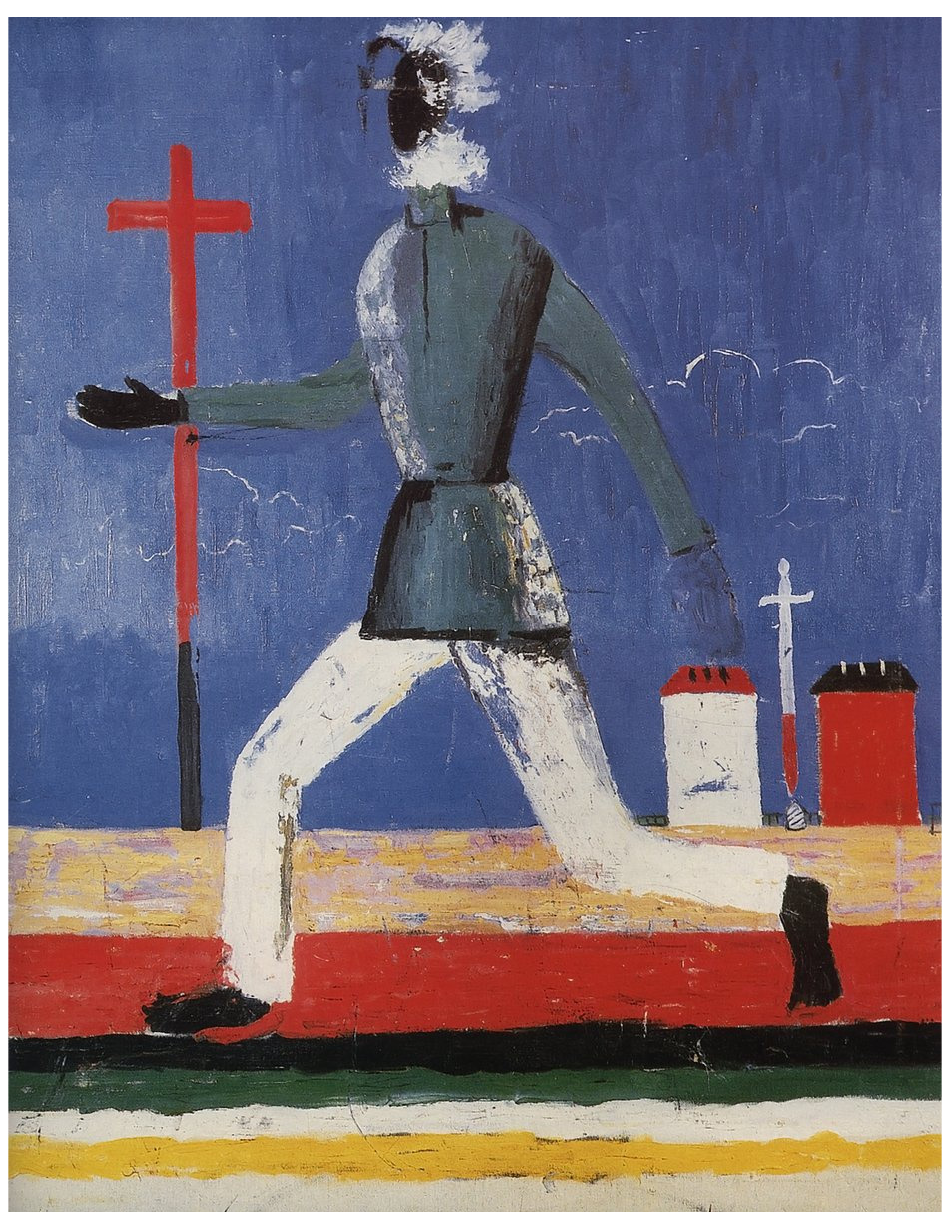
Figure 6. K. Malevich. The Running Man . 1934.